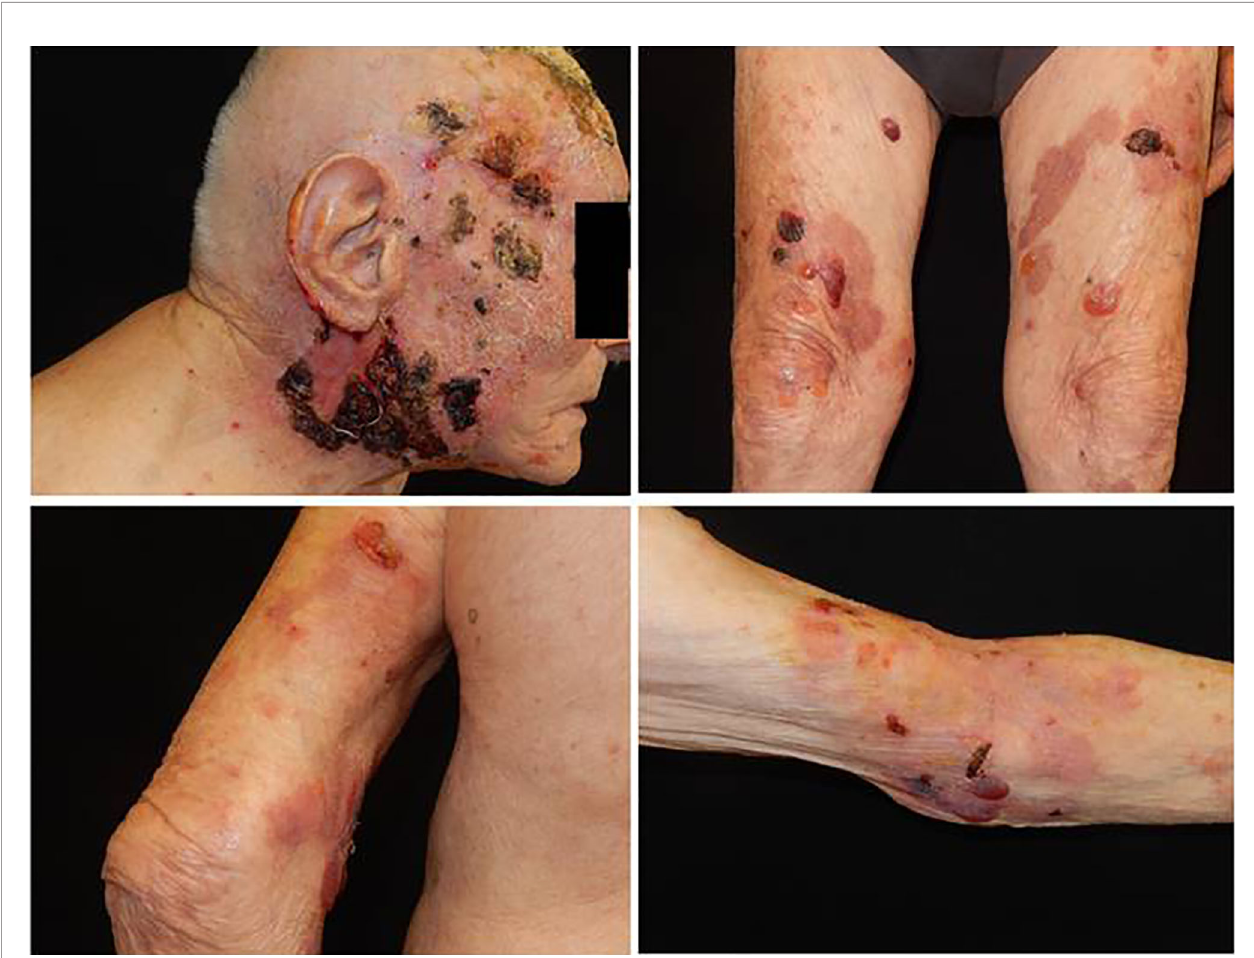
FIGURE 2 | A large necrotic haemorragic eschar on the head (face and scalp), with ulcers and serohematic scars associated with blisters over skin, with serum content, localized on the trunk and